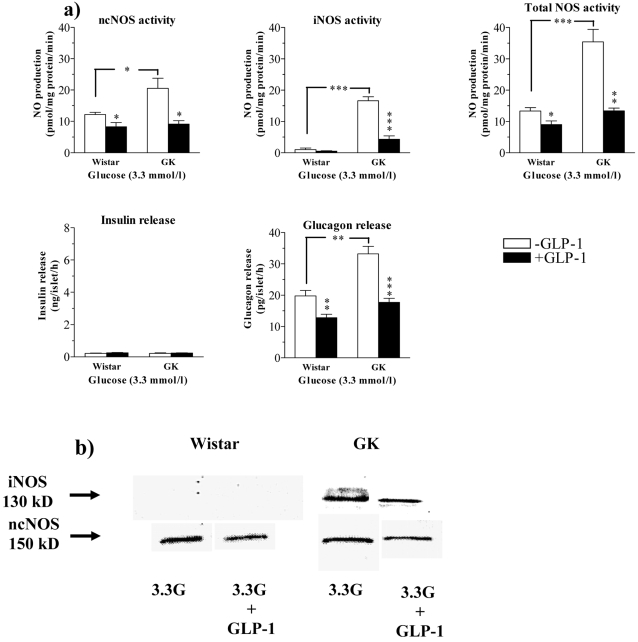
(a) NOS activities and hormone secretion in islets incubated at low glucose. Islet NO production from ncNOS, iNOS and total NOS as well as insulin and glucagon release from islets of Wistar or GK rats incubated at 3.3 mmol/l glucose in the absence (open bars) and presence (dark bars) of 100 nmol/l GLP-1. Values are mean±s.e.m for 5–9 batches of islets at each point. *P<0.05; ** P<0.01; *** P<0.001. (b) Representative examples of Western blots of iNOS and ncNOS protein in the absence and presence of GLP-1 are shown.